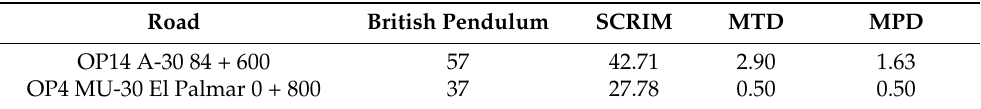
Table 5. Measures with British Pendulum and SCRIM on A-30 and MU-30.